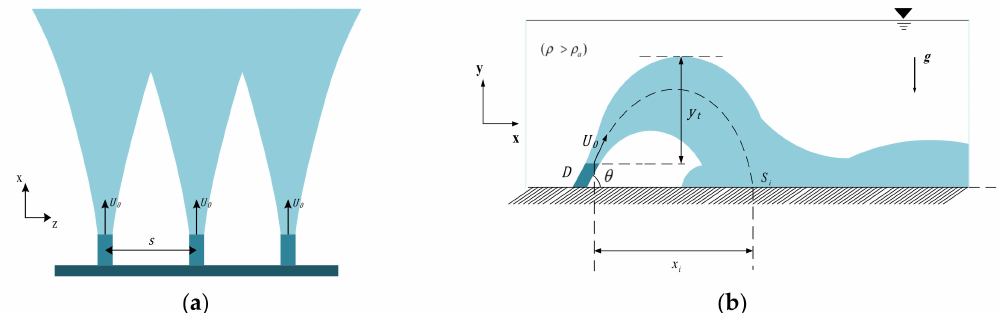
Figure 1. Schematic ( a ) plan and ( b ) side views of multiple inclined dense